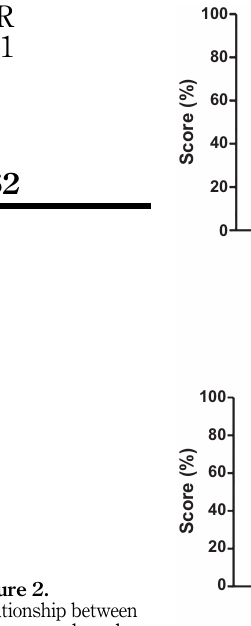
Figure 2. Relationship between sex, age, grade and club activity with knowledge of